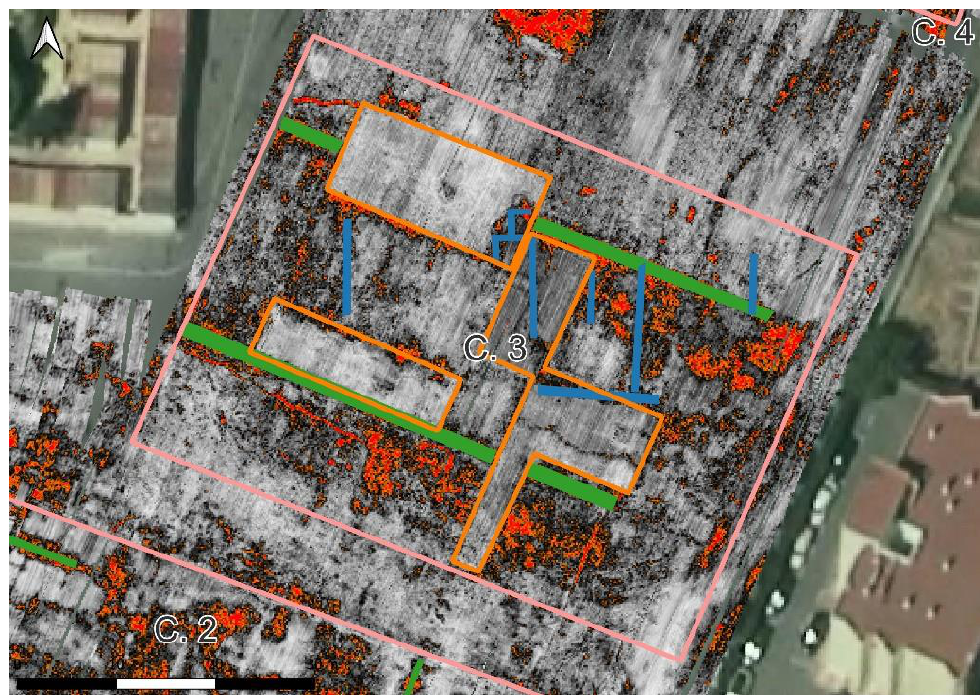
Figure 7. Detail of Set 3 in the central part of the study area showing (orange) the alterations of the subsoil by recent actions.